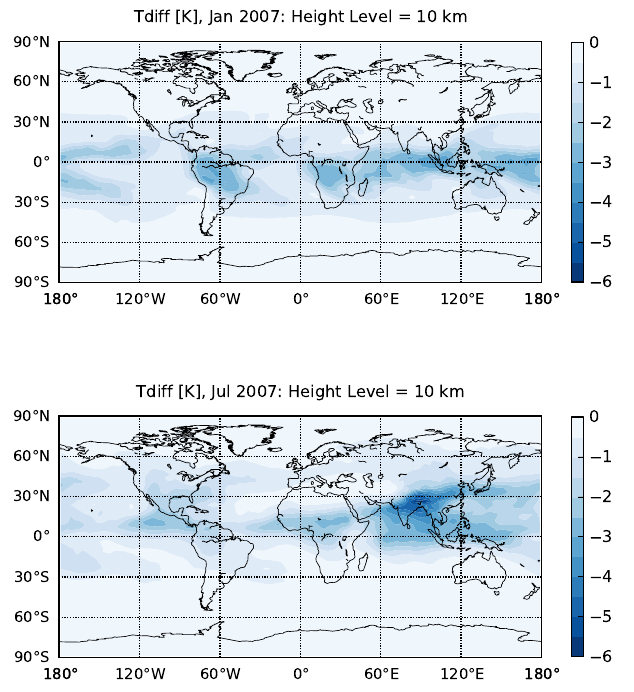
Figure 3. Difference between dry and physical temperature at a geopotential height of 10 km for January 2007 (top) and July 2007